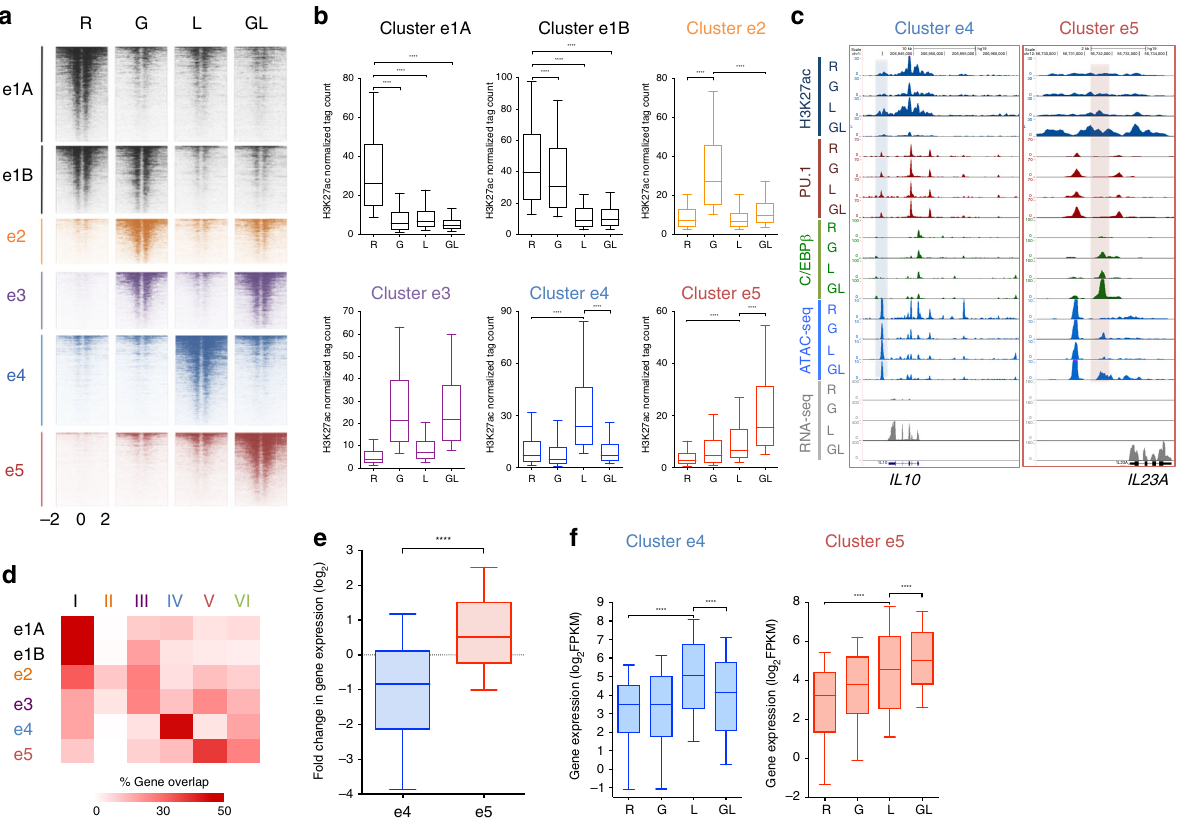
Fig. 2 Selective regulation of LPS-activated enhancer landscapes by IFN- γ . a K-means clustering (K = 5) of enhancers as shown in Supplementary Fig. 2a further fi ltered (FDR < 0.05, > 2-fold changes) and subdivided into six enhancer clusters. Heatmaps showing H3K27ac ChIP-seq signals at each enhancer cluster. b The boxplots indicate normalized tag counts at each enhancer cluster. **** p < 0.0001, paired-samples Wilcoxon signed-rank test. Boxes encompass the twenty- fi fth to seventy- fi fth percentile changes. Whiskers extend to the tenth and nintieth percentiles. The central horizontal bar indicates the median. Data are representative of two independent experiments. c Representative UCSC Genome Browser tracks displaying normalized tag-density pro fi les at enhancers of IL10 and IL23A in four conditions. Shaded boxes enclose a cluster e4 enhancer (left) and cluster e5 enhancer (right). d Heatmap presentation of the percentage of genes in each cluster (Fig. 1a) that overlap with genes associated with the differentially regulated enhancer clusters identi fi ed in panel a . e Boxplots showing the change in gene expression between LPS and IFN- γ -primed and LPS-stimulated macrophages for the differentially expressed genes nearest (within 100 kb) to cluster e4 or e5 enhancers. **** p < 0.0001 by Welch ’ s t -test. f Boxplots showing gene expression in the four indicated conditions for e4- or e5-associated genes. **** p < 0.0001 by paired-samples Wilcoxon signed-rank test. Boxes encompass the twenty- fi fth to seventy- fi fth percentile changes. Whiskers extend to the tenth and nintieth percentiles. The central horizontal bar indicates the median. Data